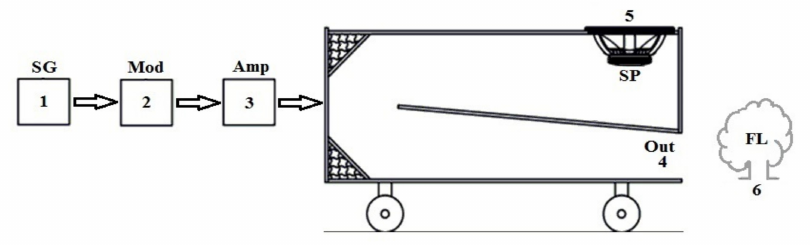
Figure 2. Components of an example acoustic extinguisher: ( 1 ) signal generator, ( 2 ) amplitude modulator, ( 3 ) amplifier, ( 4 ) device output, ( 5 ) acoustic wave source (speaker), ( 6 ) flame